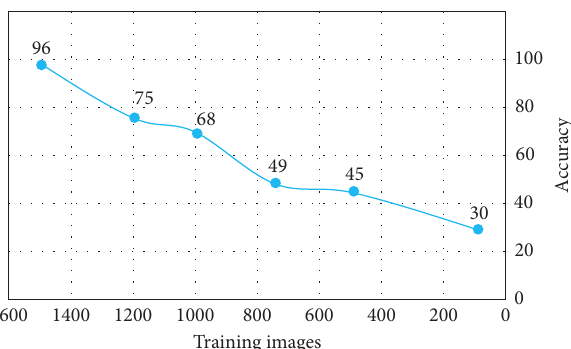
Figure 11: Accuracy of the proposed method during the training